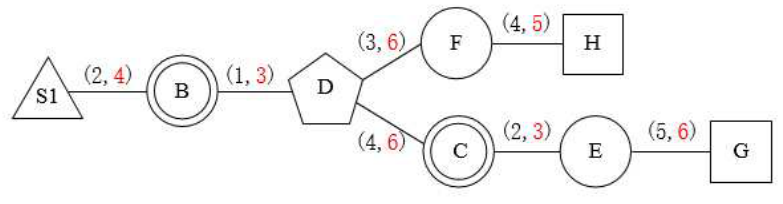
Figure 8. Constructed multicast tree.